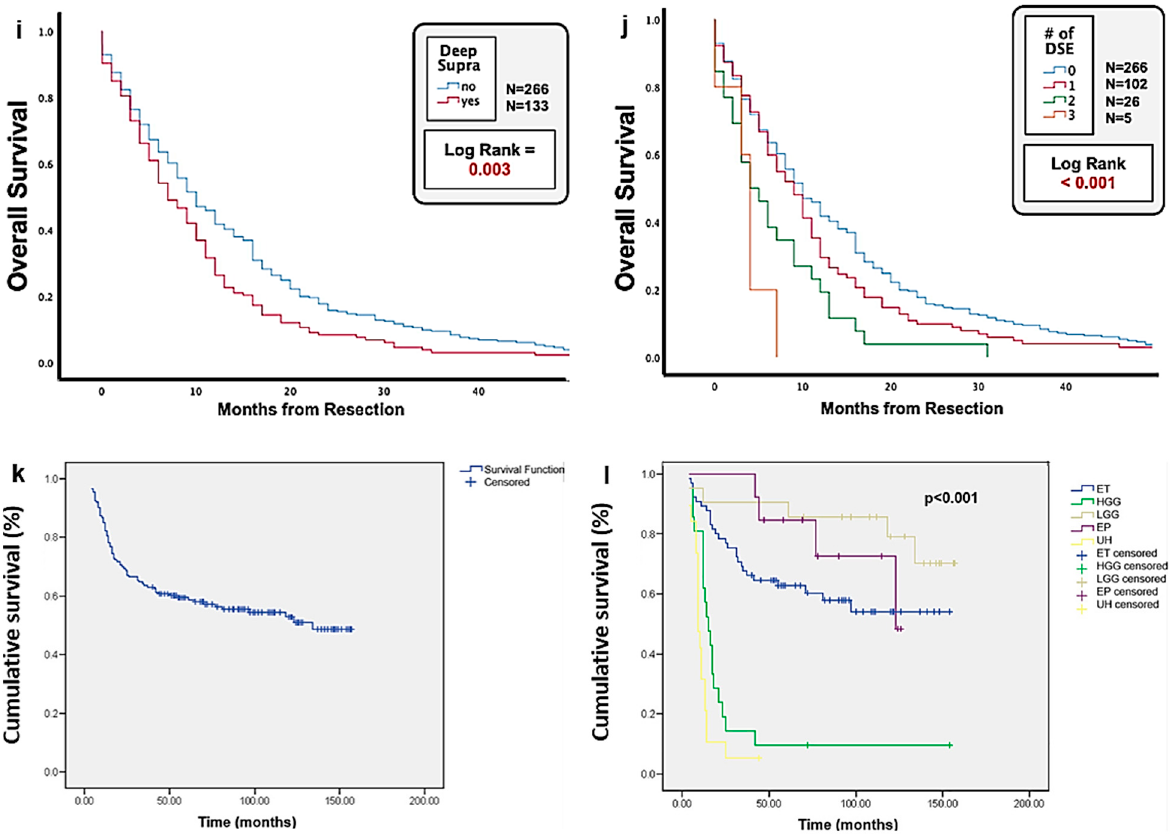
Figure 4. Advances in prognosis of HGG. Kaplan–Meier analysis of OS based on STOX1 expression levels in glioma patients. ( a – d ). Glioma patients with high-level STOX1 expression had longer OS than those with low-level STOX1 expression did among the whole glioma cohort ( a , b ) or GB cohort alone ( c , d ) in both CGGA and TCGA datasets (reproduced from [52] with permission). ( e , f ). MGMT is a marker for survival and disease progression in GB. ( e , f ). The extent, pattern, and prognostic value of MGMT promotor methylation. ( e ). Kaplan–Meier estimates of OS in GB treated with any form of radio-/chemotherapy. Curves are displayed for patients with >18 methylated CpG sites (straight lines) and ≤ 18 methylated CpG sites (dotted lines). ( f ). Kaplan–Meier estimates of radiographic progression-free survival in GB treated with any form of radio-/chemotherapy. Curves are displayed of patients with >18 methylated CpG sites (straight lines) and ≤ 18 methylated CpG sites (dotted lines) (reproduced from [54] with permission). ( g , h ). In HGG patients, 18 F-FET-PET-guided gross total resection (GTR) improves OS. ( g ). PET GTR results in longer OS (19.3 months) compared to that of patients with PET residual (13.7 months). ( h ). Patients with FET-PET examination before initial resection showing a significant effect of PET GTR (reproduced from [55] with permission). ( i , j ). HGG with deep supratentorial extension (DSE) is associated with a worse OS. ( i ). Kaplan–Meier curves reveal that GBs with DSE are associated with significantly worse OS compared to those without DSE. ( j ). Involvement of a greater number of deep-seated brain structures is associated with progressively worsening OS by pooled log-rank analysis (reproduced from [57] with permission). ( k , l ). Clinical profile, treatment, and outcome of pediatric brain tumors in Serbia over a 10-year period. ( k ). Cumulative survival of children with brain tumors. ( l ). Cumulative survival of children with brain tumors according to tumor histopathological type. ET—embryonal tumors; HGG—high- grade glioma; LGG—low-grade glioma; EP—ependymoma; UH—unknown histopathological type (reproduced from [62] with